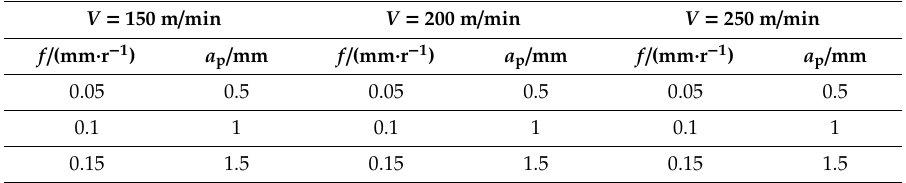
Table 2. Cutting parameters of the multi-factor orthogonal experiment.